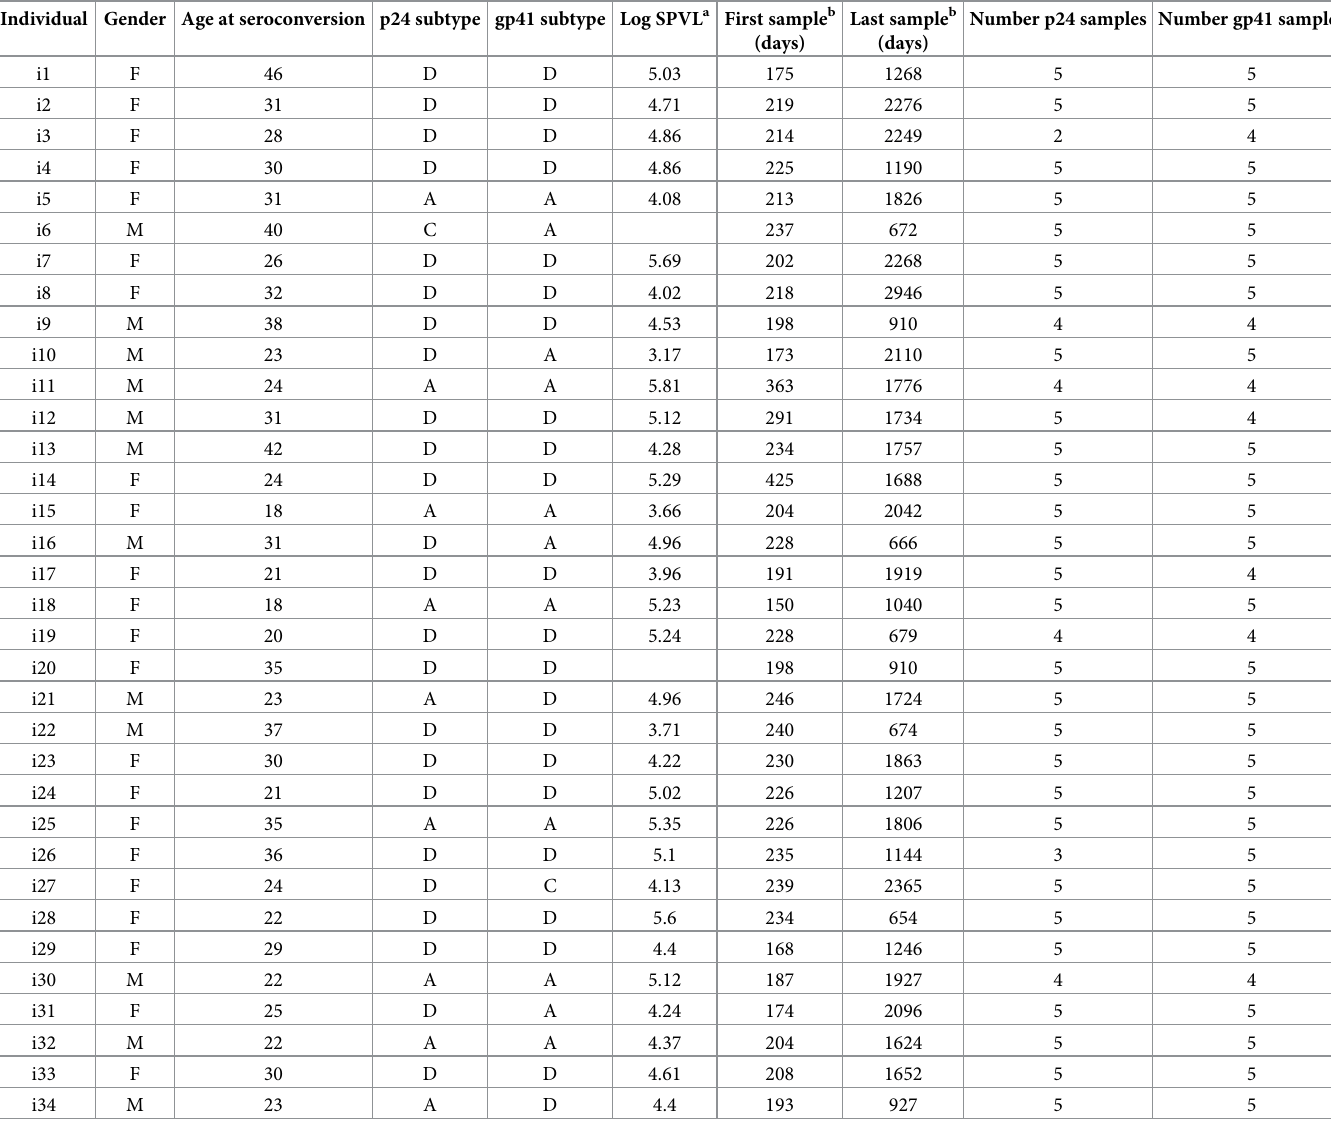
Table 1. Summary information for the 34 individuals and corresponding samples analysed in this